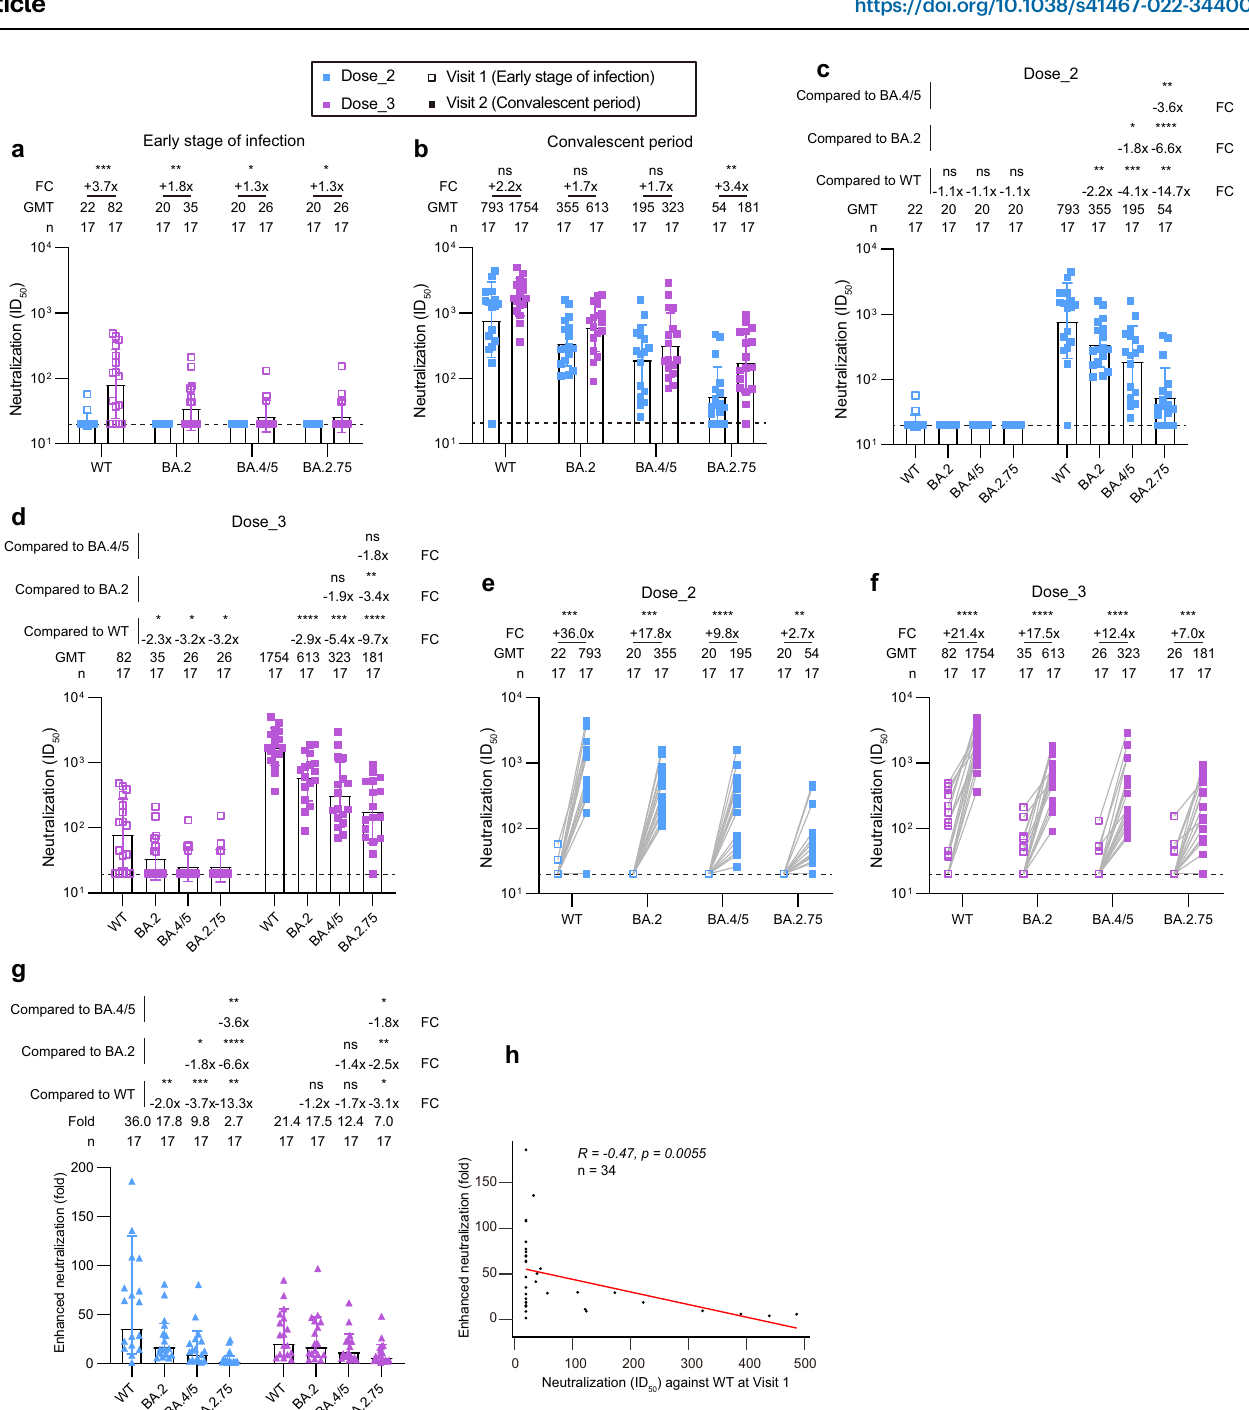
coef fi cients (R) and statistically signi fi cant P value were provided. The ID 50 values are means of at least two independent experiments. Data are presented as geo- metric mean values ± standard deviation (SD). The sample size, geometric mean, fold change, and signi fi cance of difference were labelled on the top. “ - ” represents decreased value and “ + ” represents increased value. Statistical signi fi cance was performed using two-tailed unpaired Wilcoxon test in ( a , b ), two-tailed Kruskal- Wallis test with paired Wilcoxon ’ s multiple-comparison test in ( c , d , g ), and two- tailed paired Wilcoxon test in ( e , f ). ****, P <0.0001; ***, P <0.001; **, P <0.01; *, P <0.05; ns, not signi fi cant. The dotted horizontalline in( a-f ) indicates the limit of detection (1:20dilution) for the neutralizationassay. Non-neutralization data isset as 20 for analysis and visualization. ID 50 indicates 50% inhibition dilution. GMT indicates geometric mean titer. FC indicates fold change. Source data and exact P values are provided as a Source Data fi